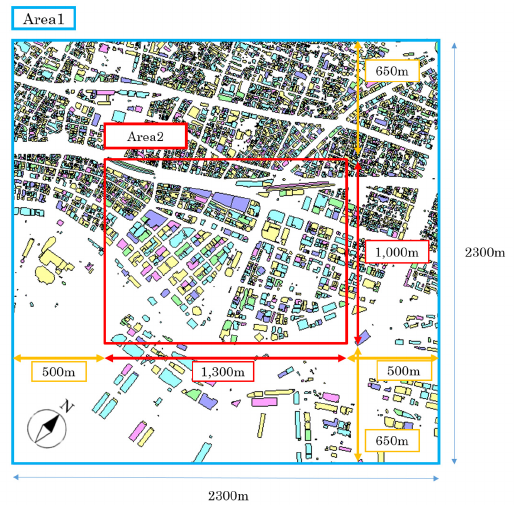
Figure 2. Calculation area (Area 1) and analysis area (Area 2).